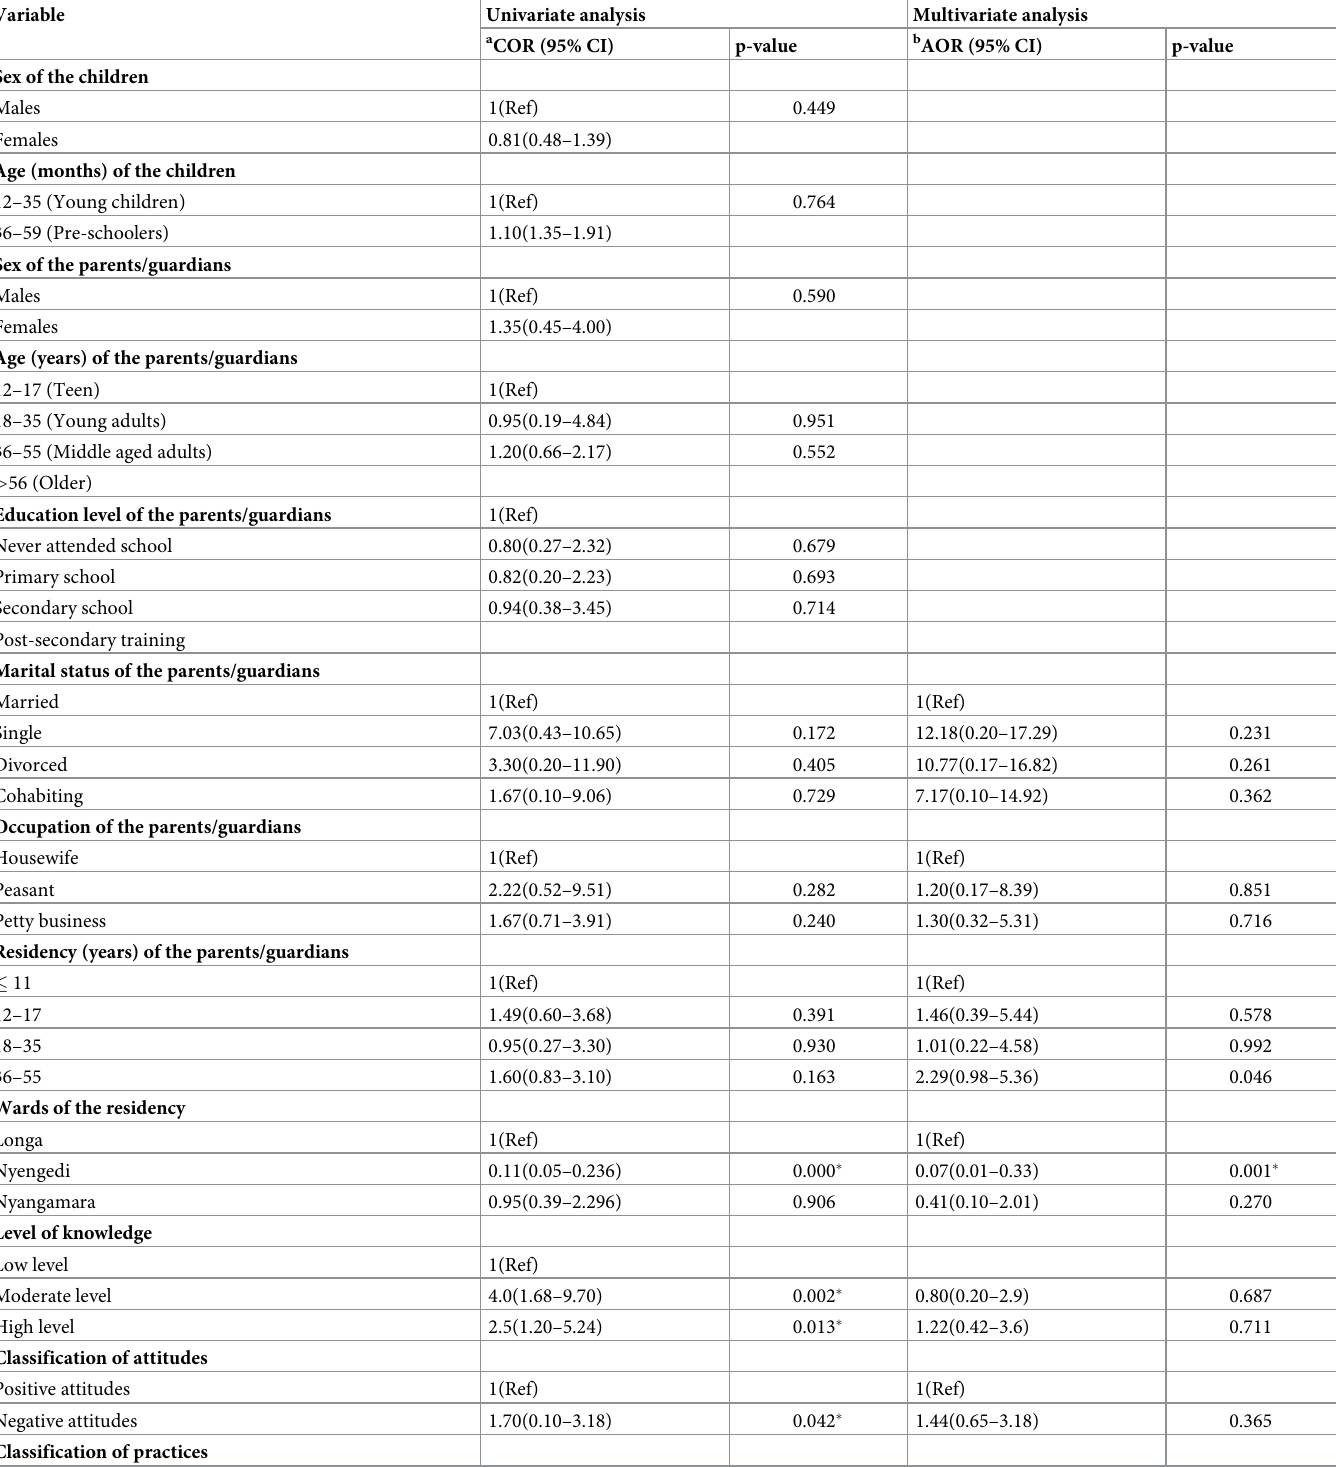
Table 7. Univariate and multivariate regression analysis of the factors associated with ongoing transmission of urogenital schistosomiasis among the under-fives (n =